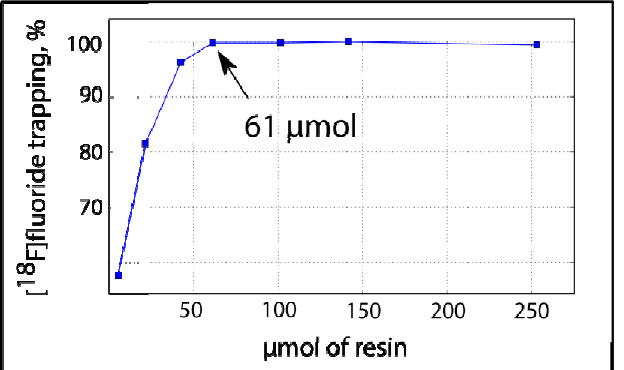
Figure 3. On-column [ 18 F]F − trapping using PS-P 2tBu : Correlation between resin amount and [ 18 F]fluoride trapping